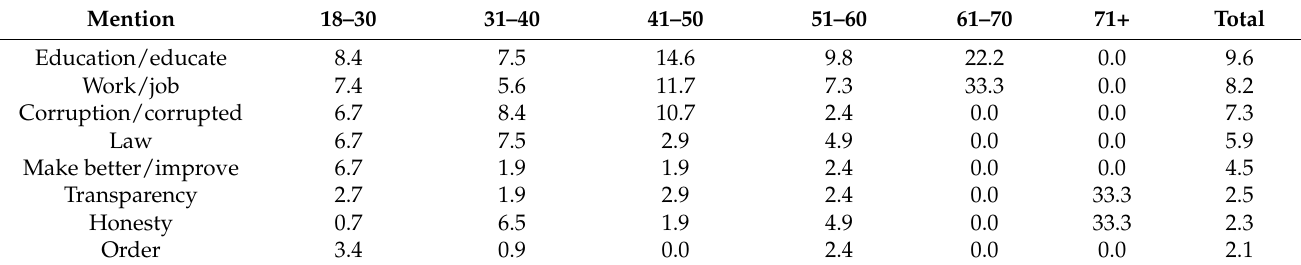
Table 10. Perception of people’s duties regarding crisis